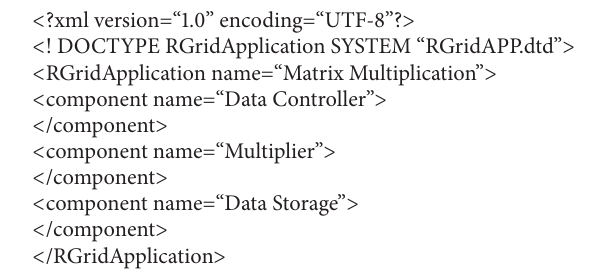
Algorithm 1: Example of an Application Descriptor.